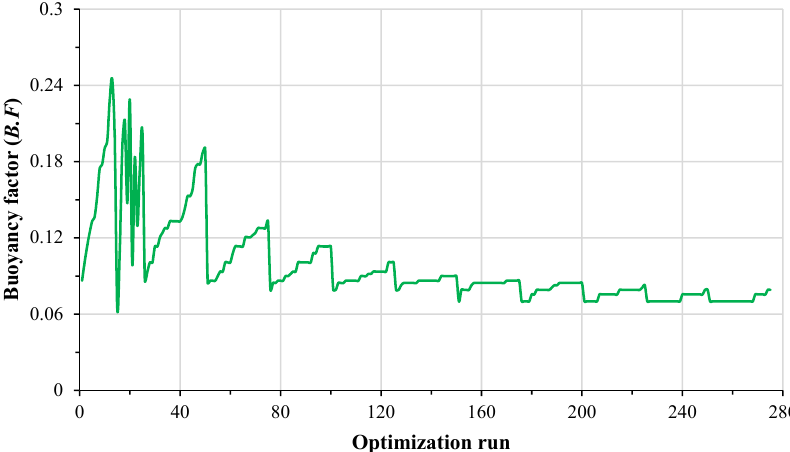
Figure 5. History plot of buoyancy factor ( B . F ) for optimization of carbon / epoxy lay-up [ β 1S / β 2T ]. Table 3. The results of parametric analysis of the spherical submersible steel hull.